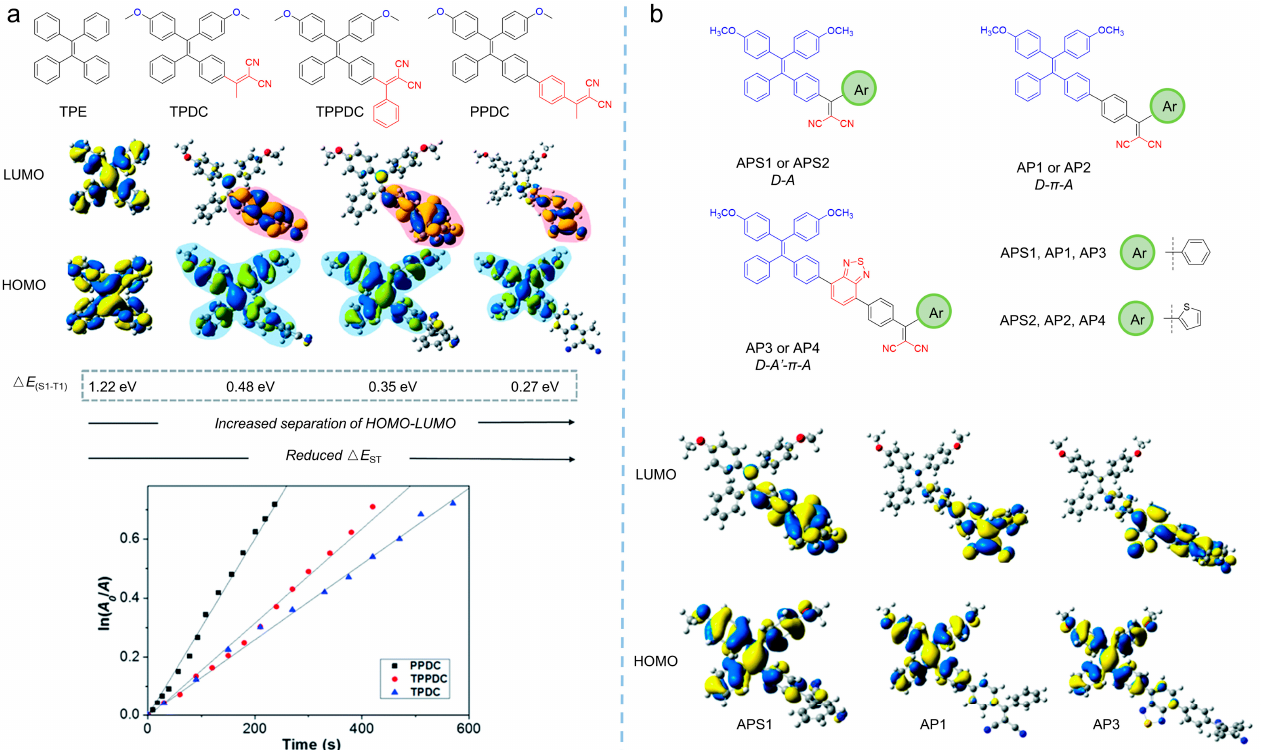
Figure 5. Donor-acceptor molecular engineering strategies to enhance ROS. ( a ) Molecular structure, calculated HOMO-LUMO distributions, and ROS generation of TPDC, TPPDC, and PPDC. Reprinted with the permission the authors of [41]. Copyright 2015, by the author(s). Published by the Royal Society of Chemistry. ( b ) Molecular structure with extended π -spacer between donor and acceptor and calculated HOMO-LUMO distributions of the TPE-based photosensitizers. Reprinted with the permission of the authors of [42]. Copyright 2017, Royal Society of Chemistry.